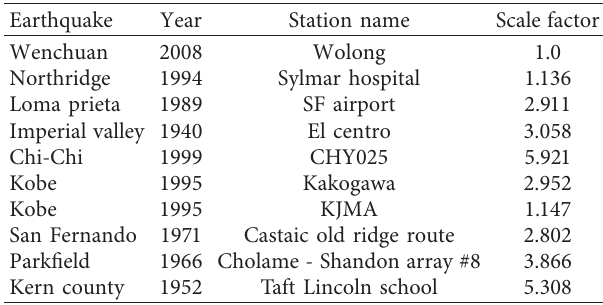
Table 6: Earthquake records for seismic analysis.